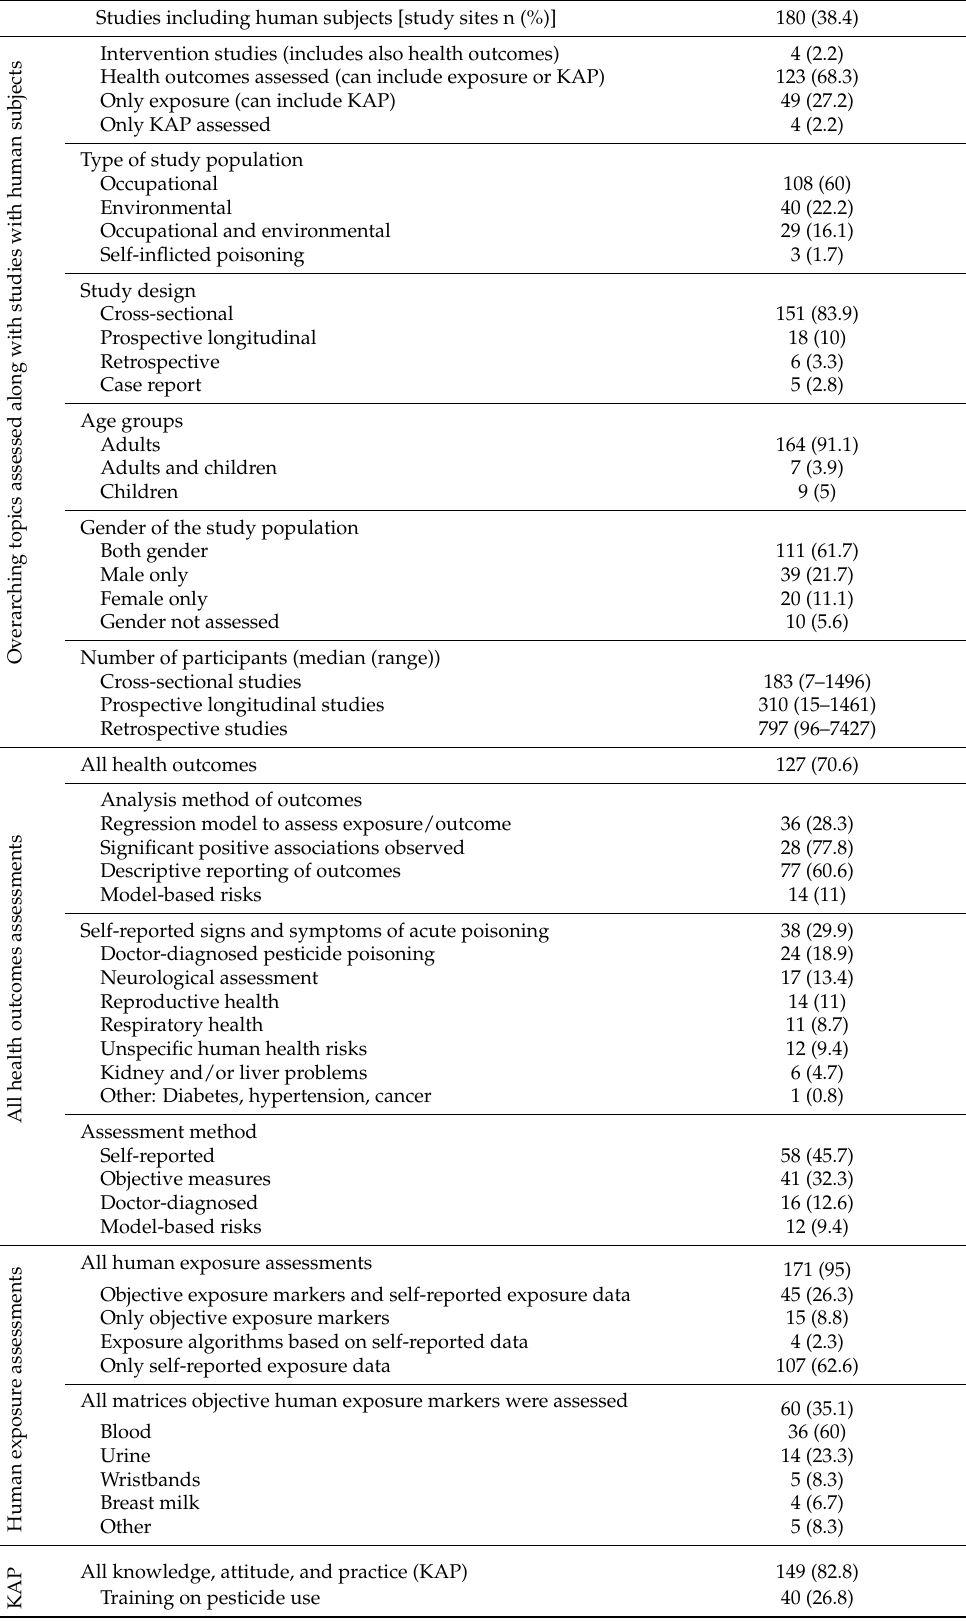
Table 2. Characteristics among the 469 study sites that collected data on human